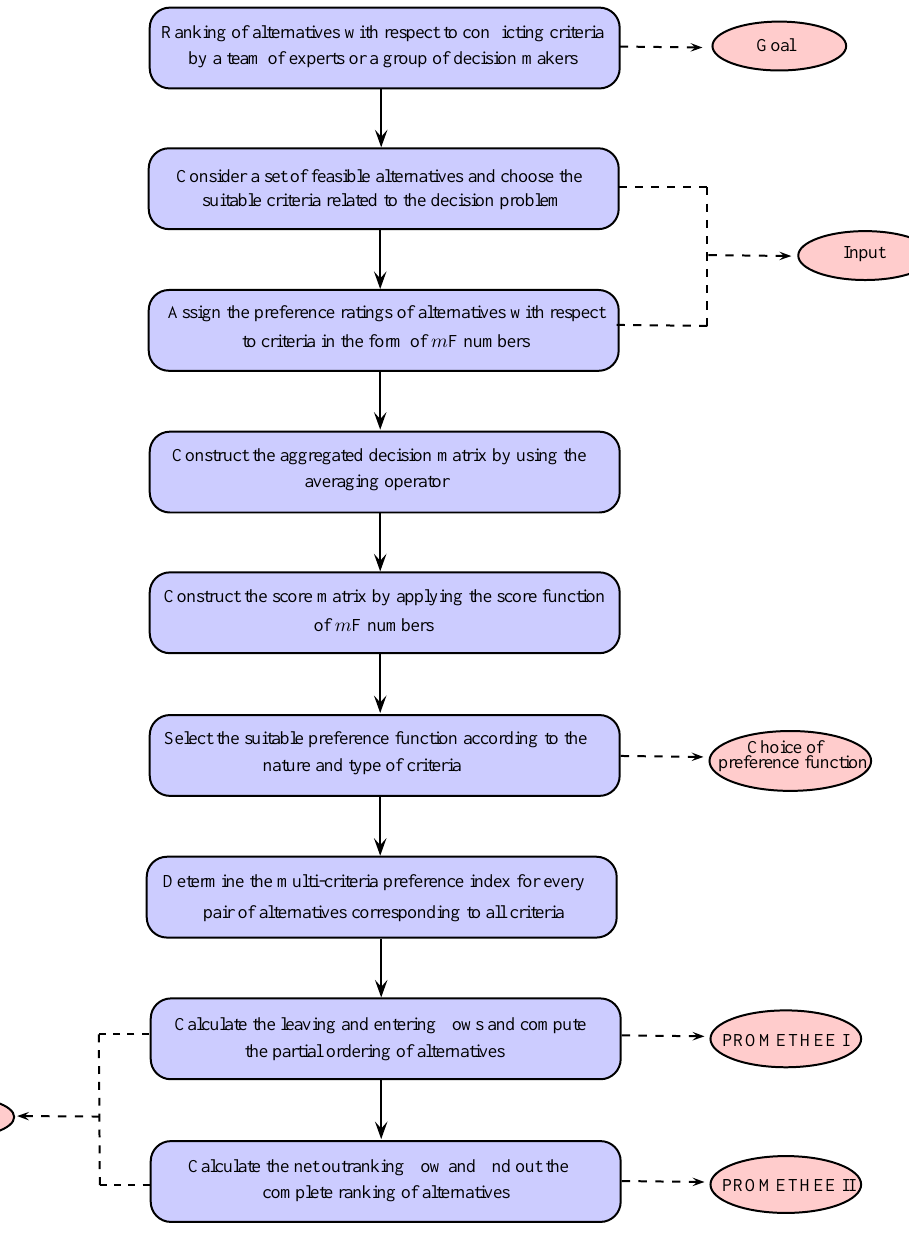
Figure 4: Flow chart of m F PROMETHEE method Figure 4. Flow chart of m F PROMETHEE